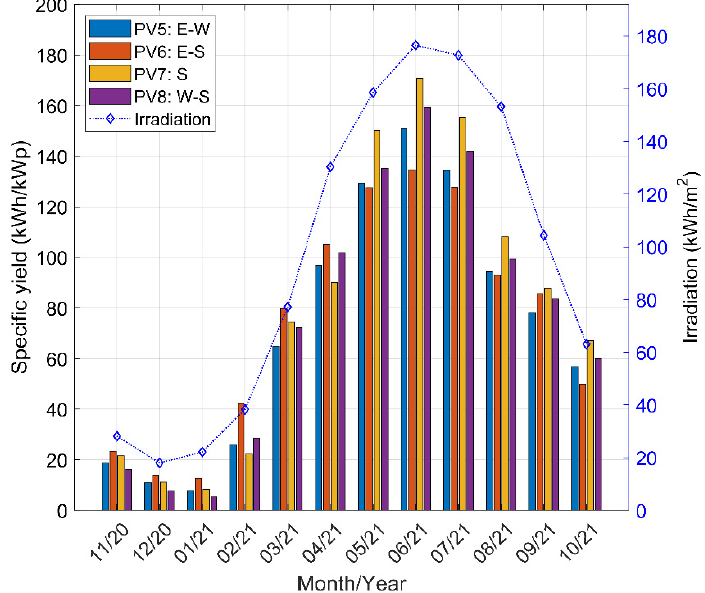
Figure 4. Monthly specific yields of PV5–PV8 rooftop systems. Irradiation was computed for 2005– 2020 using PVGIS 5.2. 2005–2020 using PVGIS